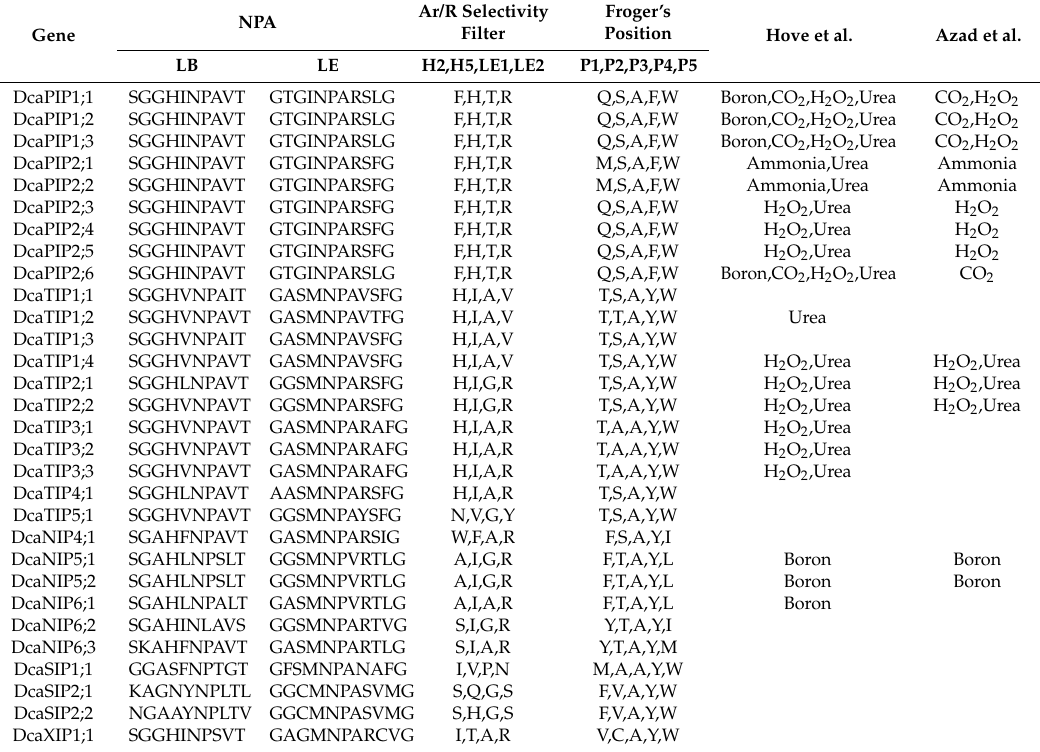
Table 2. Amino acid composition of the NPA motifs, ar/R selectivity filter and Froger’s positions of